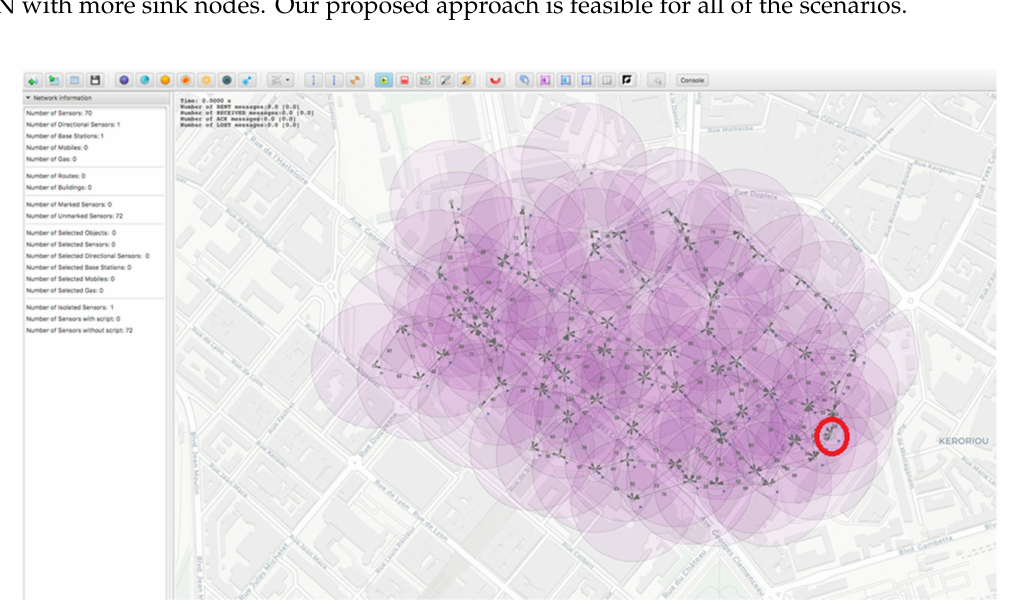
Figure 4. Sample wireless sensor network (WSN) for smart cities (generated by